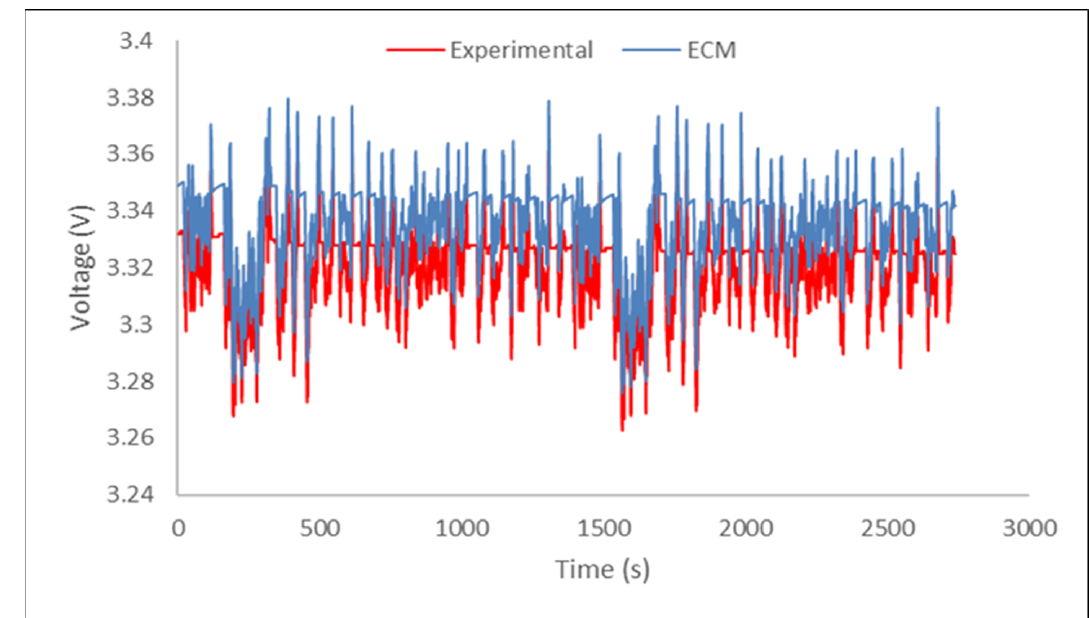
Figure 5. Cell voltage model validation plot using UDDS cycle.